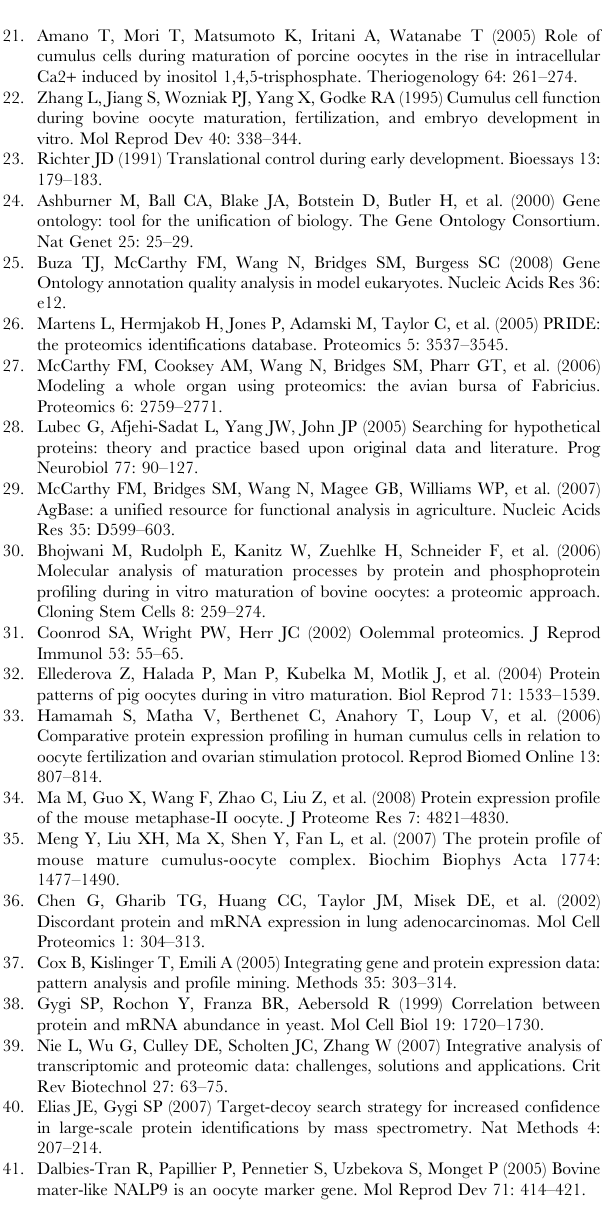
Table S3 Distribution of GV oocyte and cumulus cell proteins by subcellular compartments. The classification of the identified GV oocyte and cumulus proteins among subcellular compart- ments was performed using cellular component GO annotations.